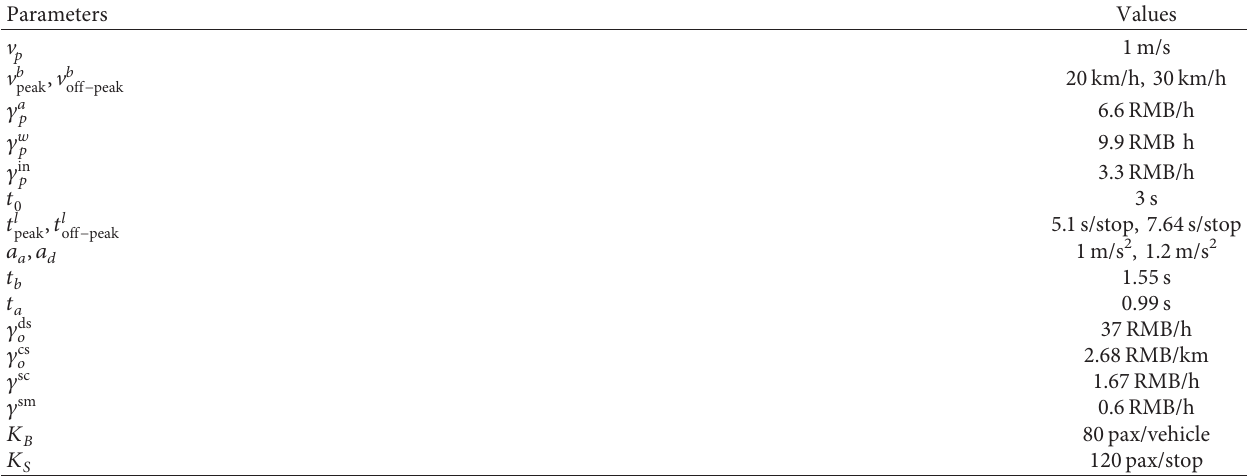
Table 2: Values of parameters.